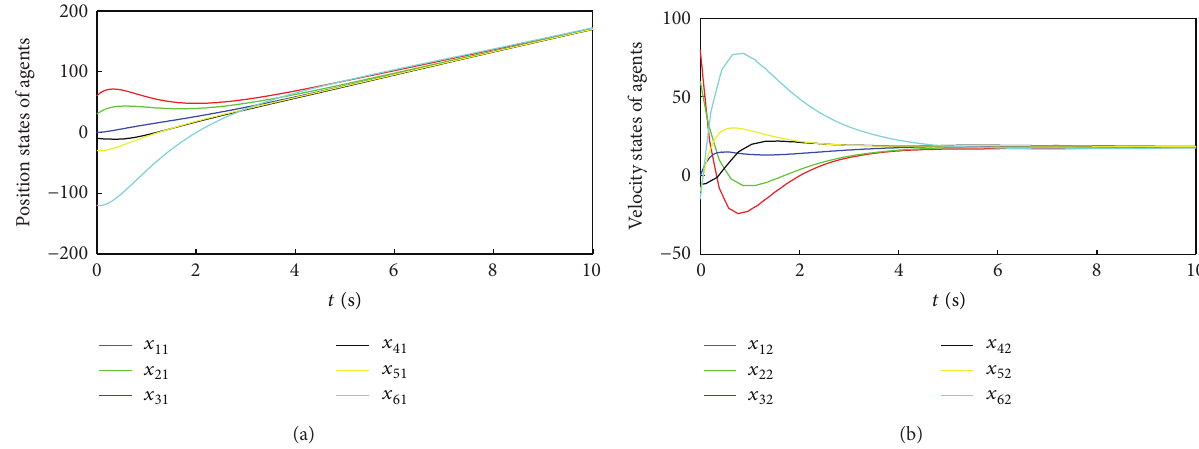
Figure 2: The evolution of states of each agent with double-integrator